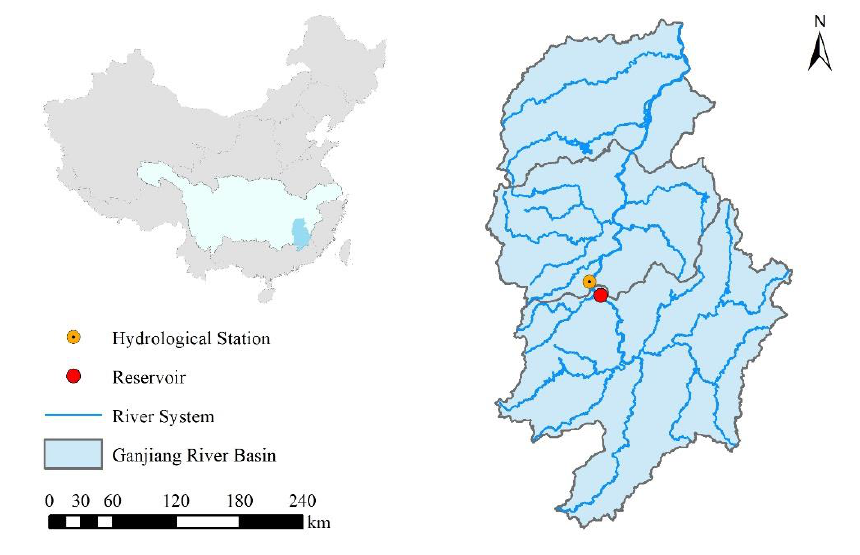
Figure 1. A brief description of the study area.